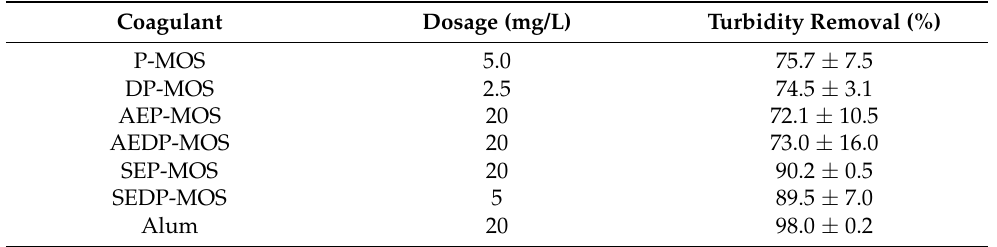
Table 3. Optimal dosages for the highest turbidity removal (%) and the lowest coagulant concen- tration (mg/L) dosage using M. oleifera seed-derived and alum coagulants. Initial turbidity was 200.8 ± 9.3